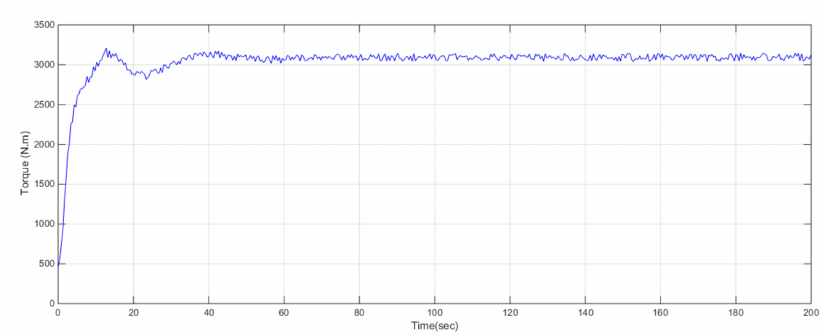
Figure 10. T d with a fault